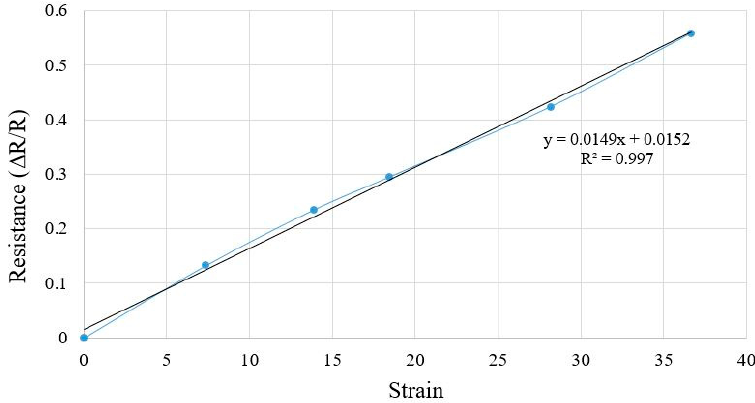
Figure 10. The response of the sensors with respect to the change in pressure for four different temperatures of 25 ˚ C, 35 ˚ C and 45 ˚ C and 55 ˚ C.